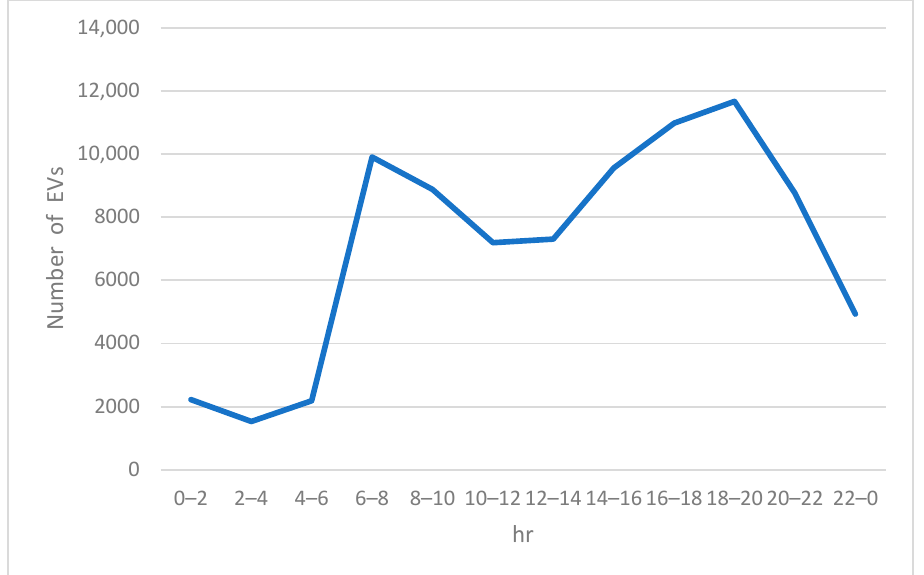
Figure 3. Number of EVs driving on the roads within a day.